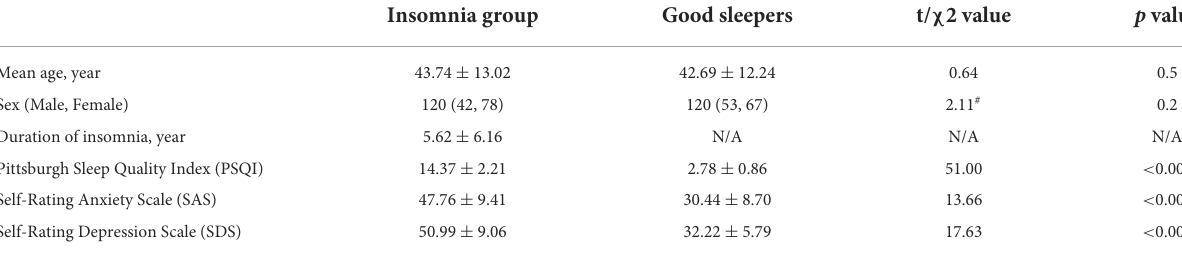
TABLE 1 Demographic characteristics of insomnia group and good